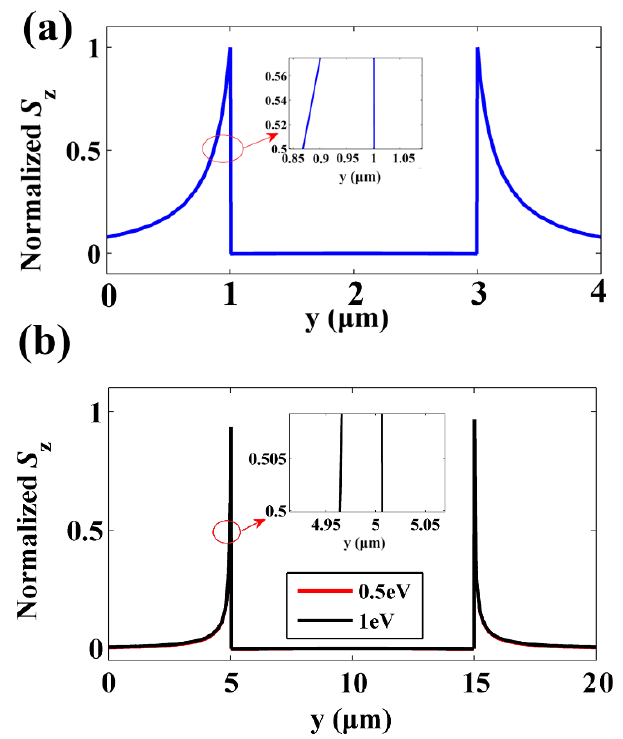
Figure 2. The time-averaged Poynting vector S z along y axis for ( a ) b / a = 2, u c = 0.5 eV, and ( b ) b / a = 10, u c = 0.5 eV, 1 eV at 3 THz. The center coordinates of the ellipses are (0, 2 µ m) and (0, 10 µ m). Here, a = 0.5 µ m, ε 1 = 2.25, and ε 2 = 1. The insets show the enlarged detail of S z . Table 1. The mode properties versus b / a , and a = 0.5 µ m, u c = 0.5 eV, ε 1 = 2.25, and ε 2 = 1. b / a n e ff L P ( µ m) FWHM